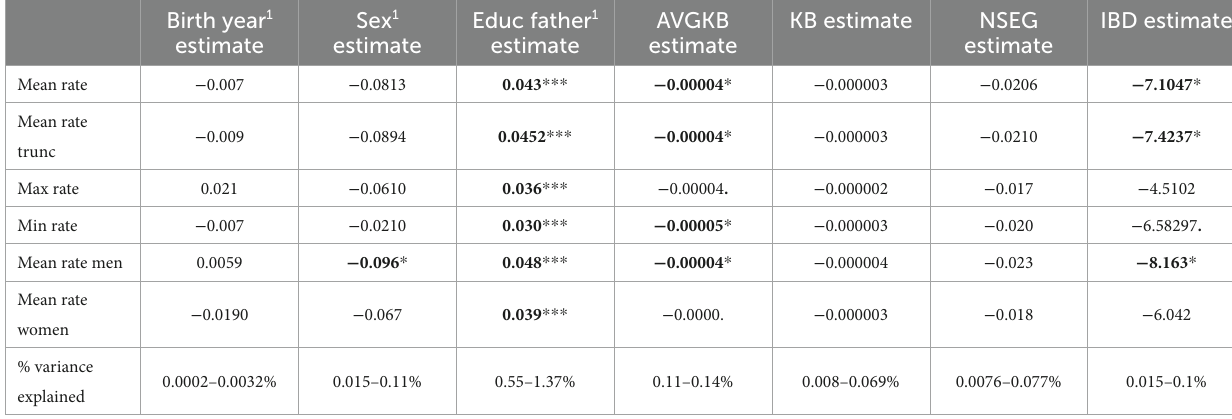
TABLE 1 Results of the separate linear models of mean rate, mean rate trunc, max rate, min rate, mean rate men and mean rate women, respectively, regressing on birth year, sex, education of the father, AVGKB, KB, NSEG, and IBD.